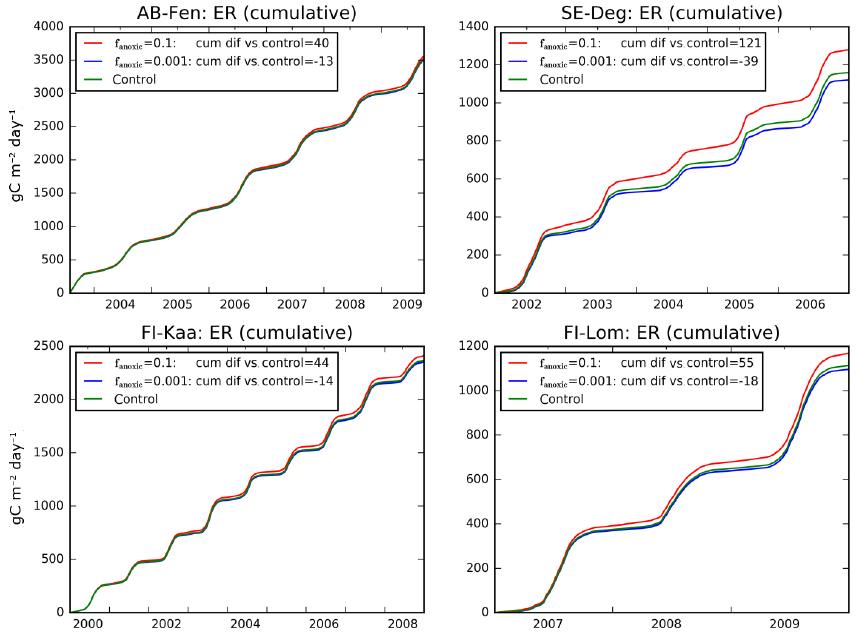
Figure 20. Effect of varying f anoxic on the ER flux for the four fen sites. The control run was with f anoxic set to